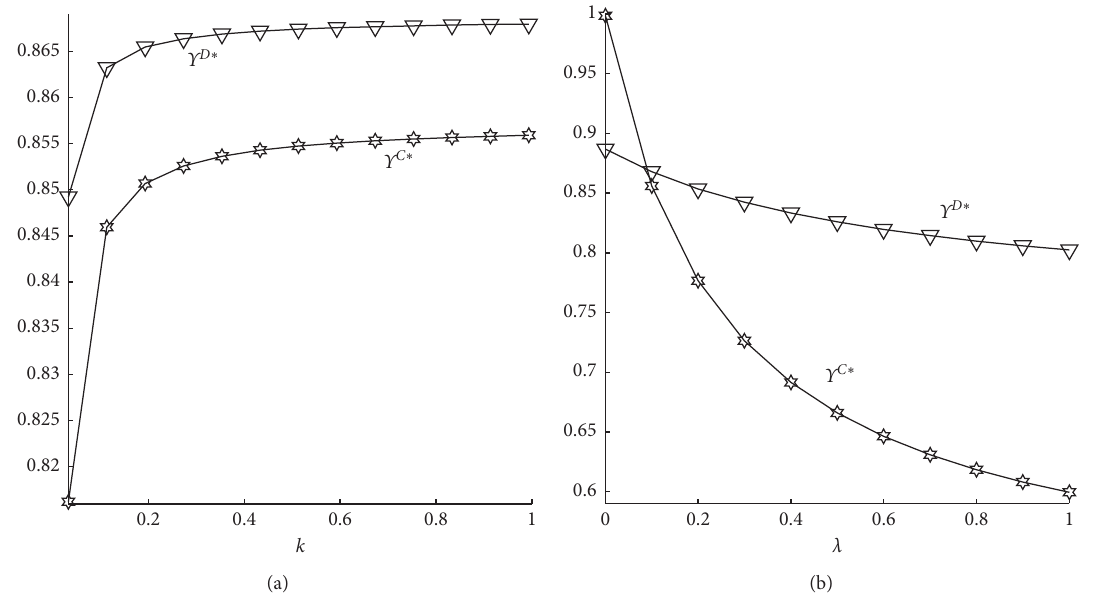
Figure 1: The impact of k and λ on Υ C ∗ and Υ D ∗